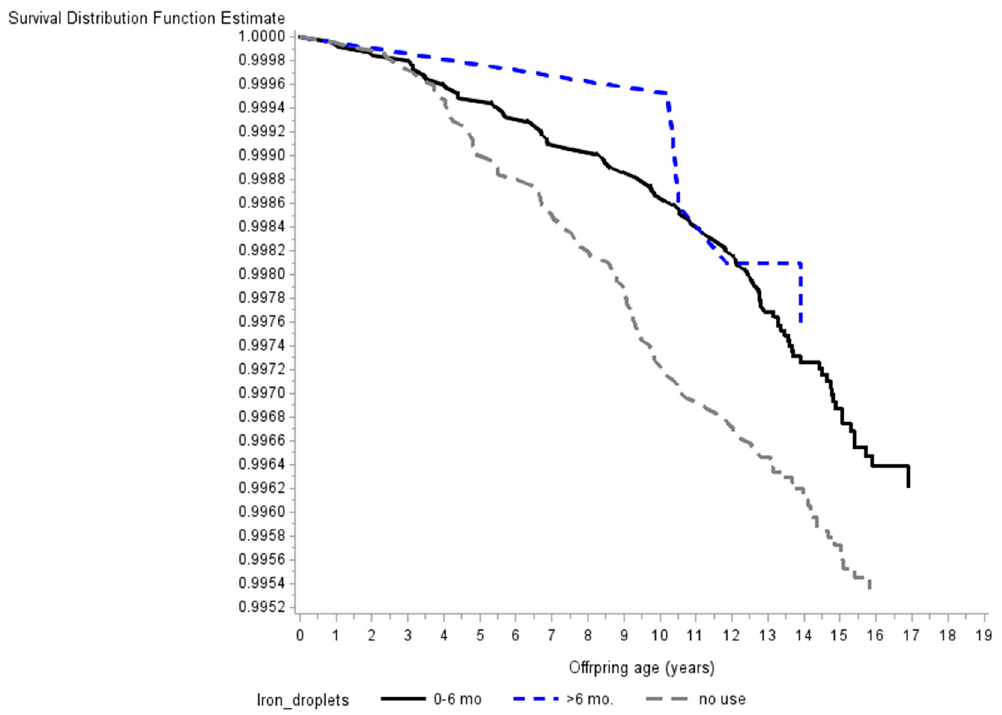
Figure 1. Survival curve illustrating the inverse association between early life supplementation with iron droplets and the risk of childhood type 1 diabetes. p -values for trend and effect are seen in Table 3. Note that the y-axis does not begin at zero.